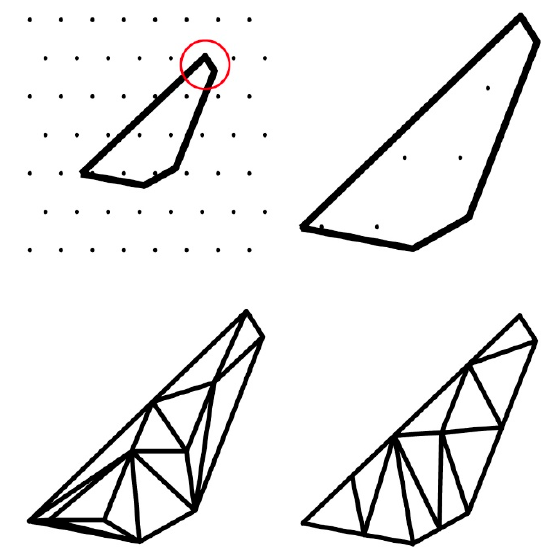
Figure 4. Rough determination of equidistant nodes by meshing techniques; Top left: background grids (black points) and the shape of the tomographic region (irregular polygon), the shortest edge has been highlighted by the red circle; Top right: initial grids of the tomographic region selected from the background grids; bottom left: a Delaunay triangulation for the initial grids; bottom right: the position of the grids (triangles vertices) moved by the meshing techniques to the roughly equally spaced position.